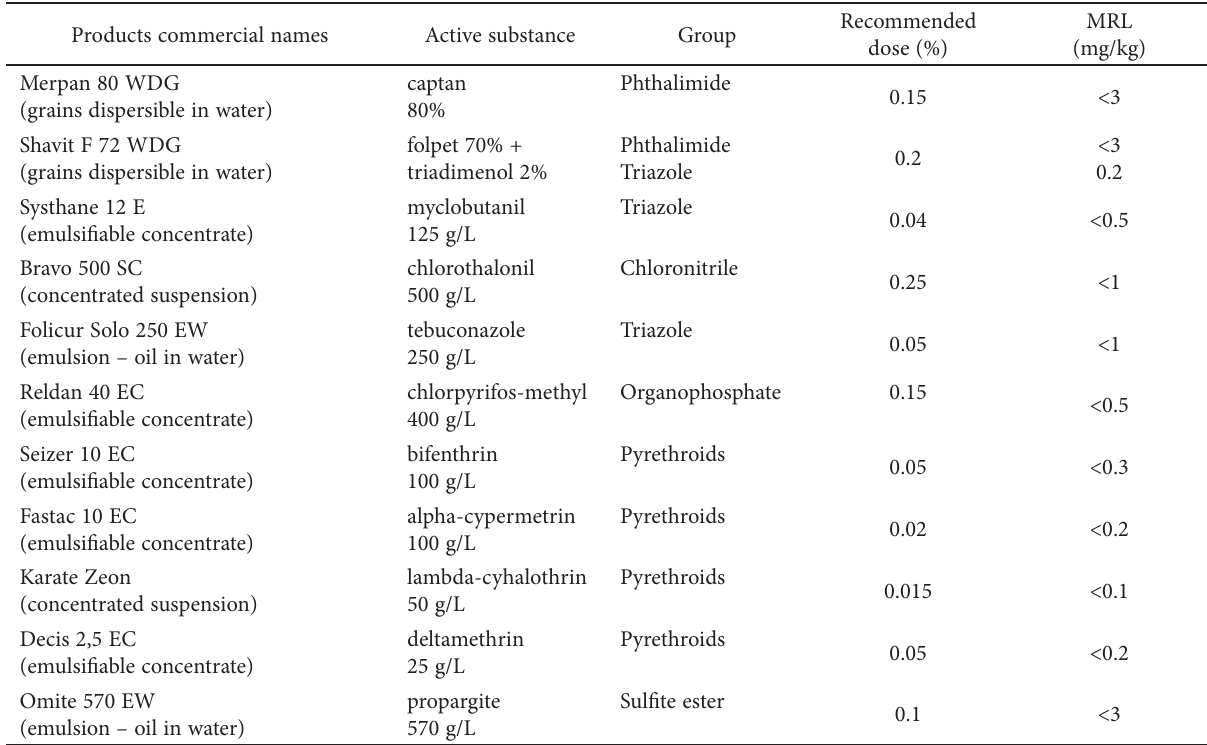
Table 1. Commercial name of products, doses, and MRL* of targeted